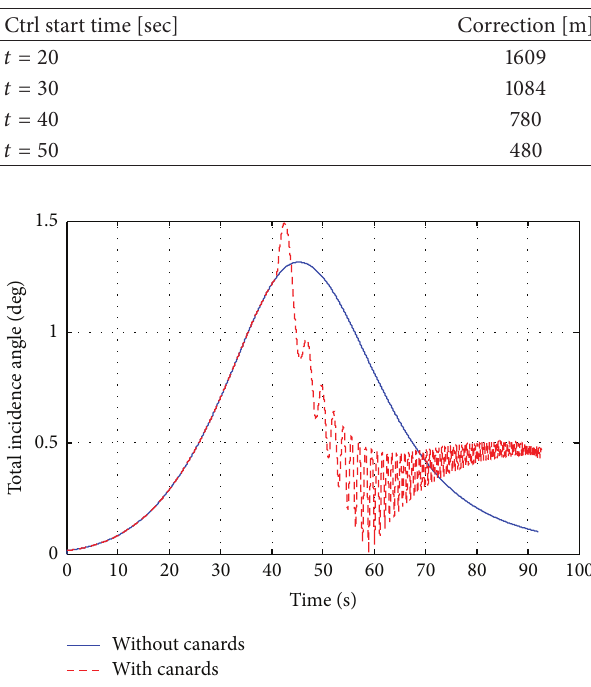
Table 2: Correction versus occasion time.